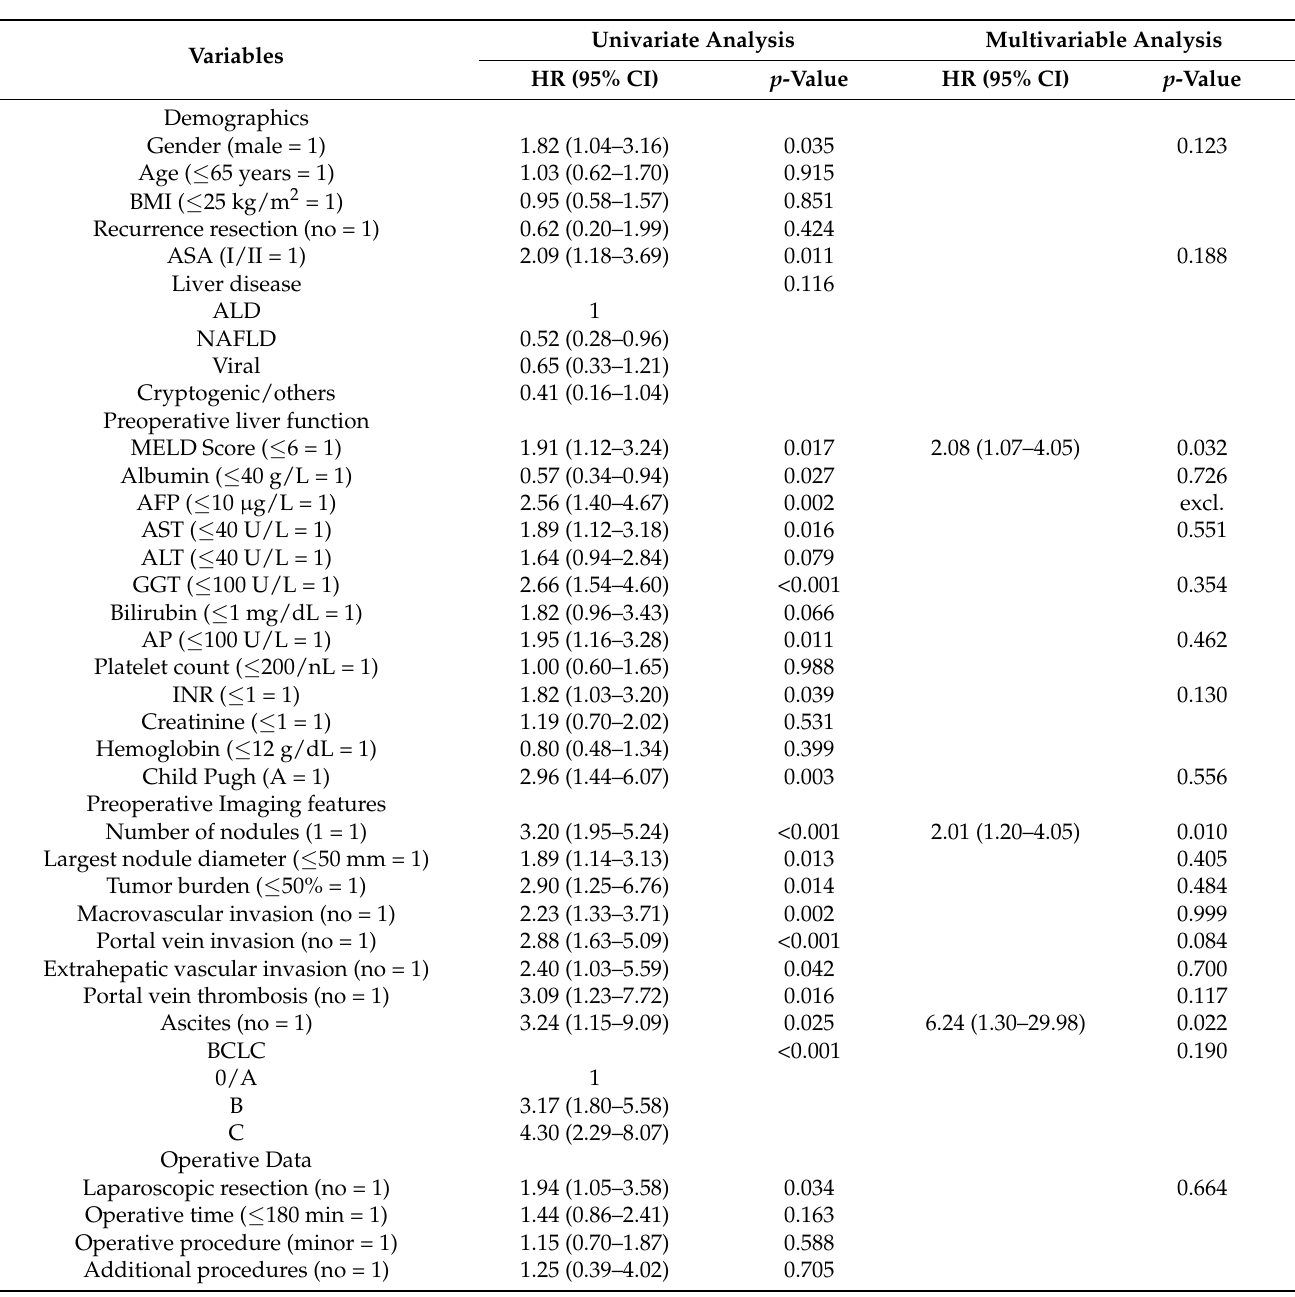
Table 2. Univariate and multivariable analysis of overall survival in hepatocellular